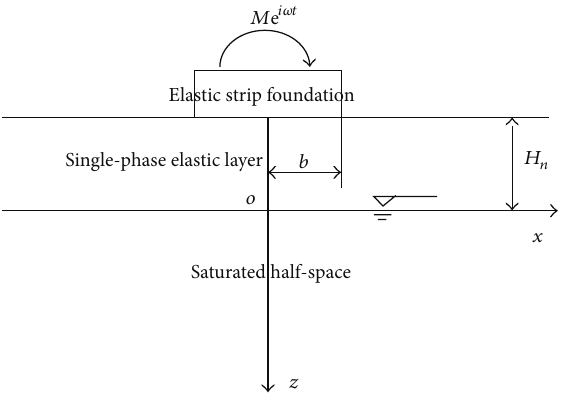
Figure 1: Description of the model and coordinate